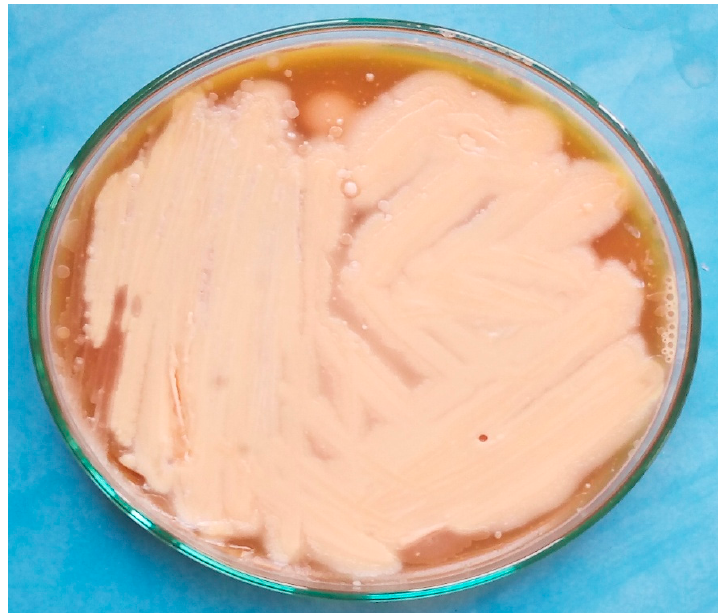
Figure 2. Anaerobic egg yolk medium inoculated with C. botulinum showing lipase-positive colonies.